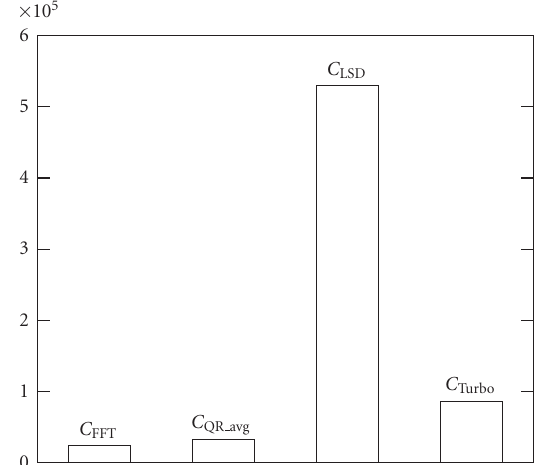
Figure 3: Required number of clock cycles of the processing tasks in T FFT = 71 microseconds time